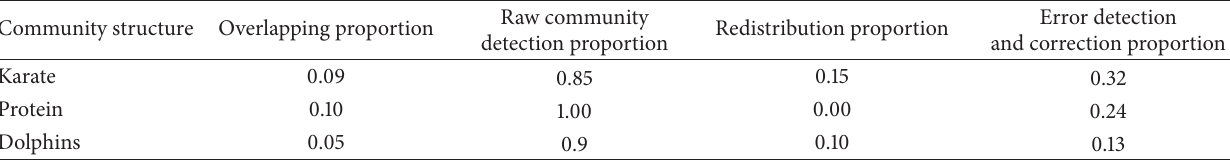
Table 5: The proportion of overlapping nodes and nodes of each stage in the